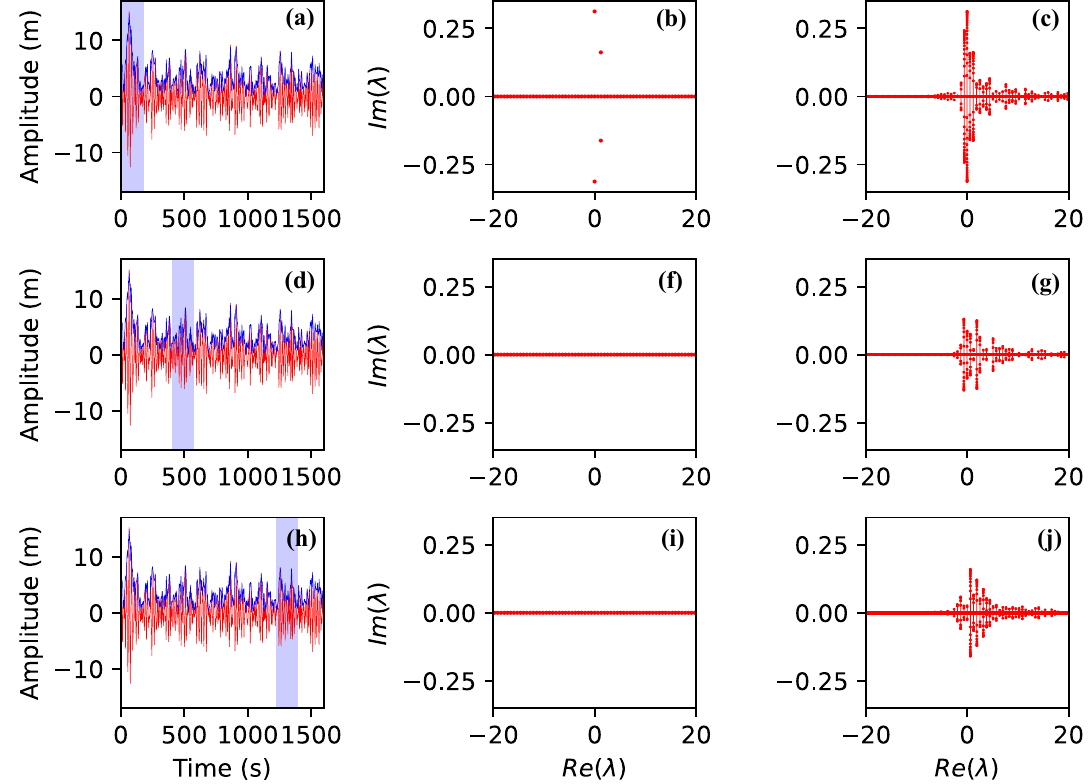
Figure 4. Left column: the signal recorded by the buoy is plotted in red line. The blue lines represent the modulus of the envelope computed by using Hilbert transform method. The blue shaded area indicates the region considered for the nonlinear spectral analysis. In the three cases reported in the left column, the width of the time window used for IST analysis is 180 s. Central column: discrete IST spectra computed using the experimental signal plotted in the blue shaded regions shown in the left column: zero boundary conditions (ZBC) are applied. Two discrete eigenvalues are found well above the real axis only for the large wave packet (see upper line). Right column: the spectra computed using the experimental signal plotted in the blue shaded regions shown in the left column: periodic boundary conditions (PBC) are applied. With these boundary conditions, spines crossing the real horizontal axis are obtained instead of discrete eigenvalues that are obtained with ZBC. Using PBC spines are spectral signatures of nonlinear modes. In ( c ) two spines of large amplitude are obtained when the giant wave packet is analyzed. Those two spines are not found when the window of analysis does not overlap the giant